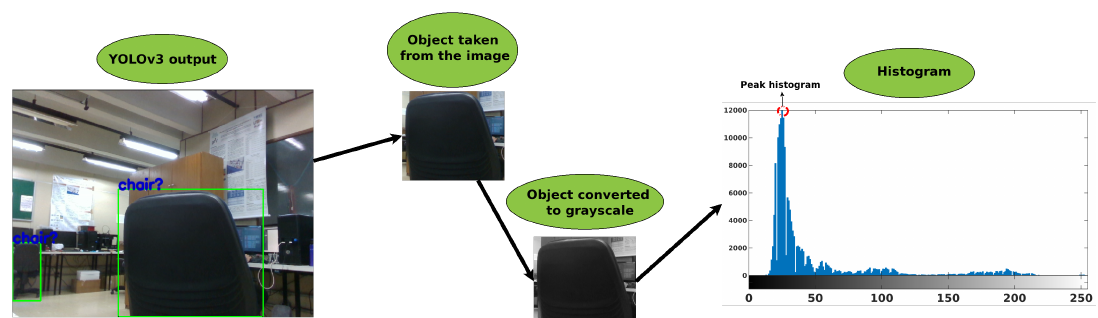
Figure 5. Analysis of